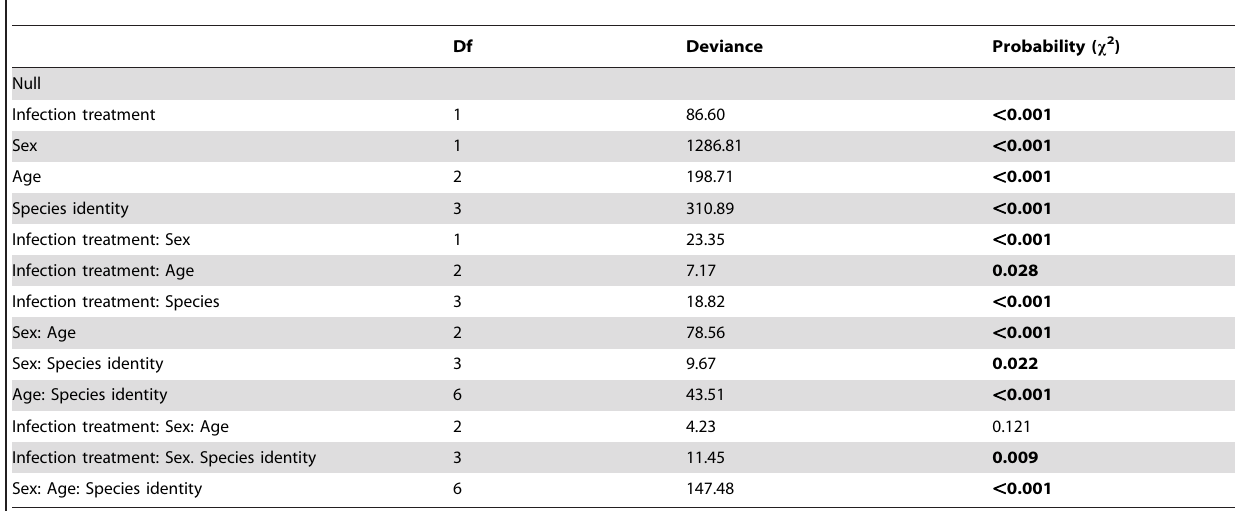
Table 7. Survival analyisis concerning the effects of infection treatment (parasite-treated and parasite-control), sex, age and species identity.